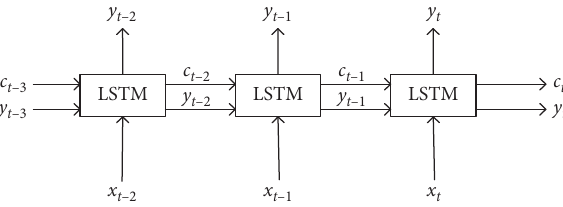
Figure 7: The prediction frame of the LSTM model. Table 3: Comparison of ration consumption prediction results in China (2014–2018) (unit: ten thousand